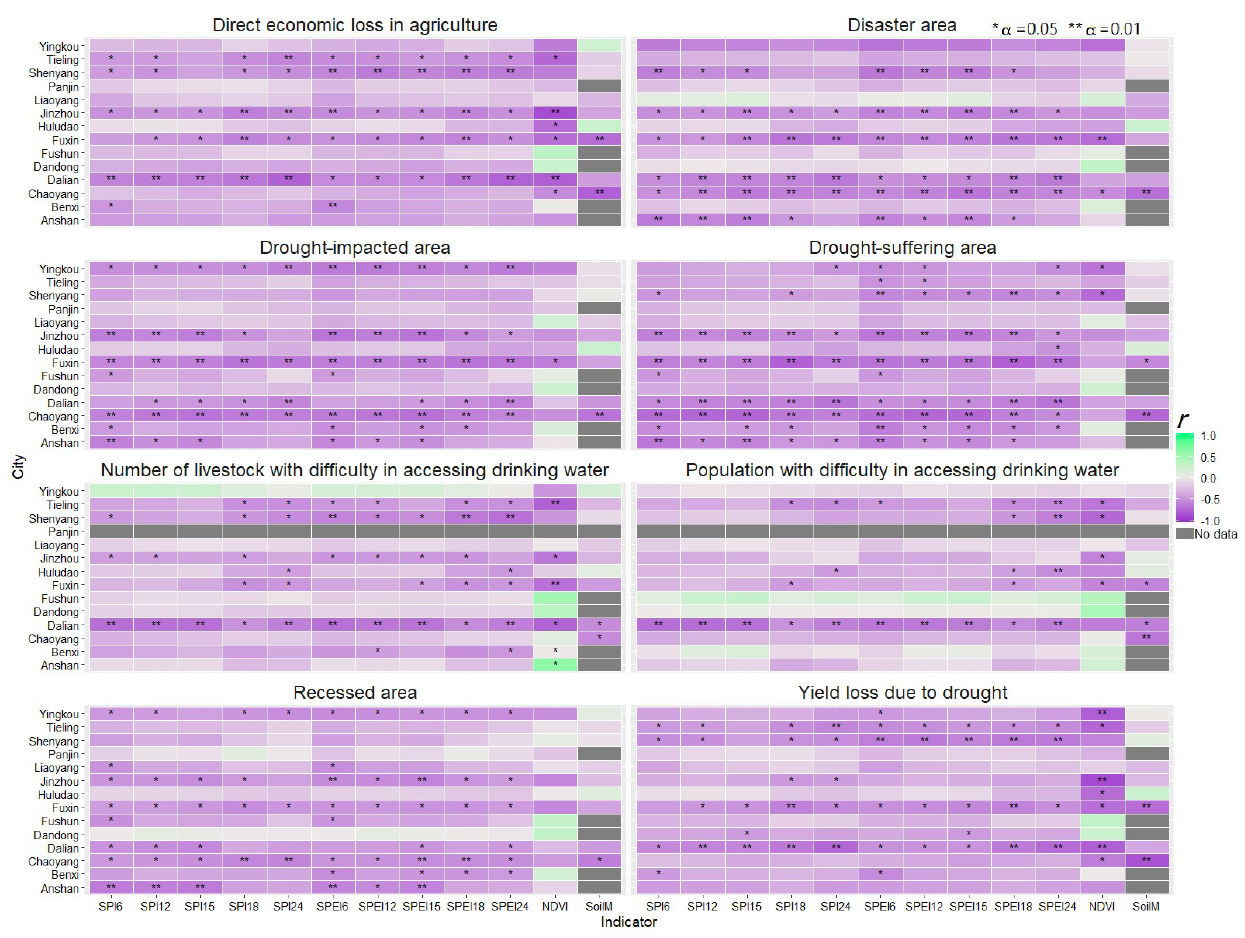
Figure 4. Correlation coefficient ( r ) between drought indices (SPI, SPEI, NDVI and SoilM) and drought impacts for different impact types (identified by the codes in Table 1) in Liaoning province. The significance level of the correlation is indicated using